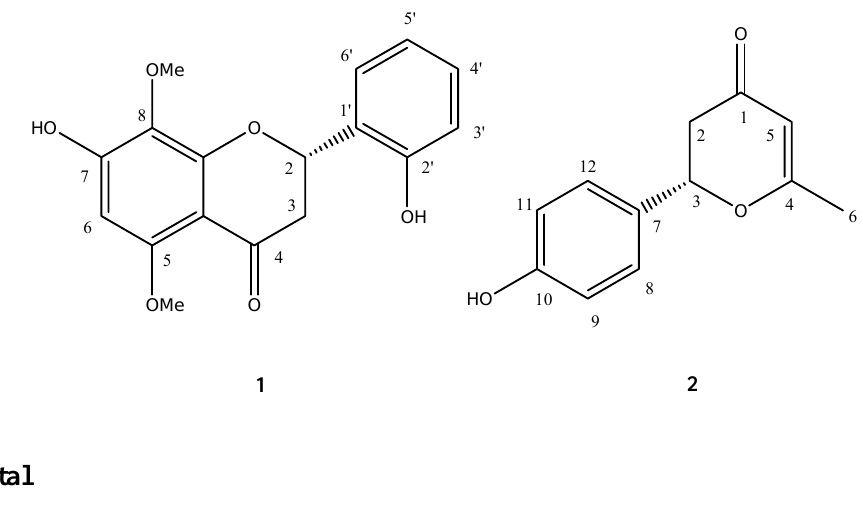
Figure 1. Structures of compounds 1 and 2